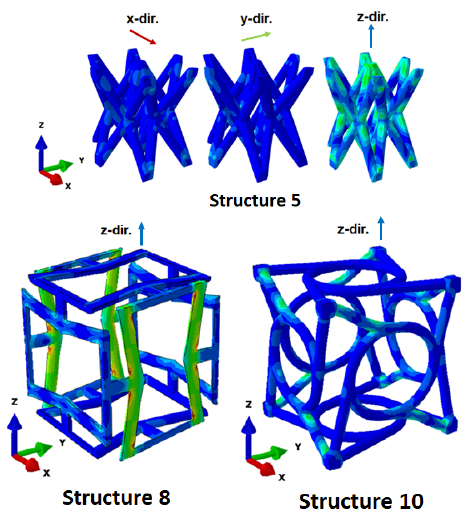
Figure 7. Illustration of the auxetic behaviour of Structure 5, 8 and 10.